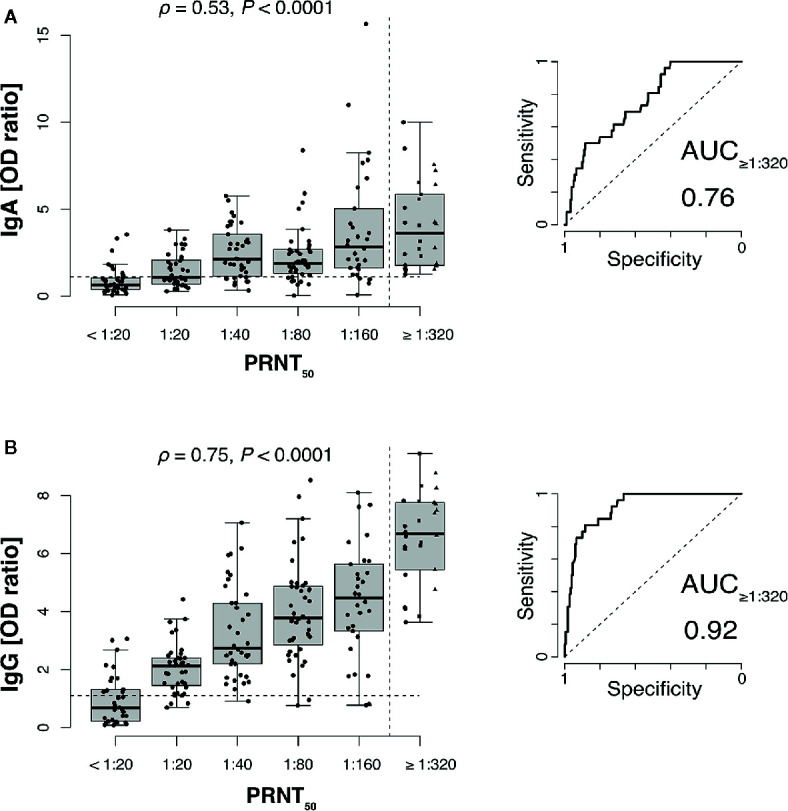
SARS-CoV-2 neutralizing antibody titers correlate with anti-S1 IgG and to a lesser extend with IgA antibodies. Plaque reduction neutralization test (PRNT50) titers of 206 plasma donors were correlated with anti-S1 IgA (A) and anti-S1 IgG (B) ELISA measurements (ρ, Spearman’s rank correlation coefficients). Values for 1:320, 1:640 (squares), and 1:1,280 (triangles) titers were pooled into a single category (≥1:320) to gain sufficient per-category sample sizes and to represent the recommended minimum titer for convalescent plasma therapy (dashed vertical line). Dashed horizontal lines indicate ELISA positivity cutoffs provided by the manufacturer EUROIMMUN). Right panels show receiver-operator characteristics (ROC curves) for prediction of a PRNT50 titer of at least 1:320 (AUC, area under the curve).